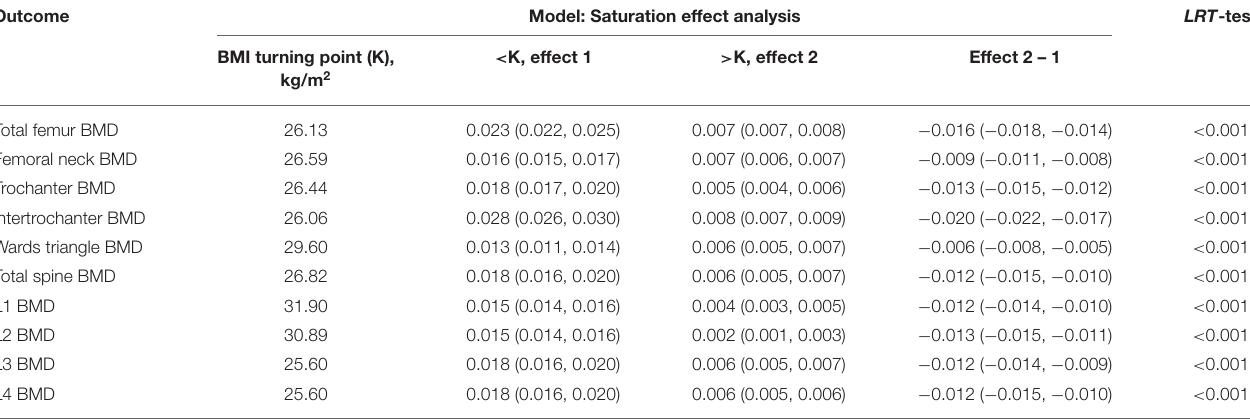
Results in the table: β (95% CI). Outcome: Total femur BMD, Femoral neck BMD, Femoral neck BMD, Trochanter BMD, Intertrochanter BMD, Wards triangle BMD, Total spine BMD, L1 BMD, L2 BMD, L3 BMD, L4 BMD. Exposure: BMI (kg/m 2